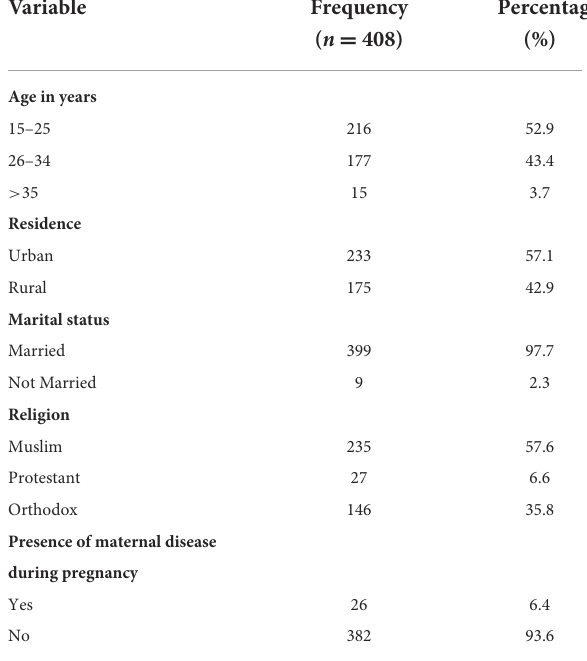
TABLE 1 Socio-demographic characteristics of women who gave birth in the Hiwot Fana Specialized University Hospital, Eastern Ethiopia,